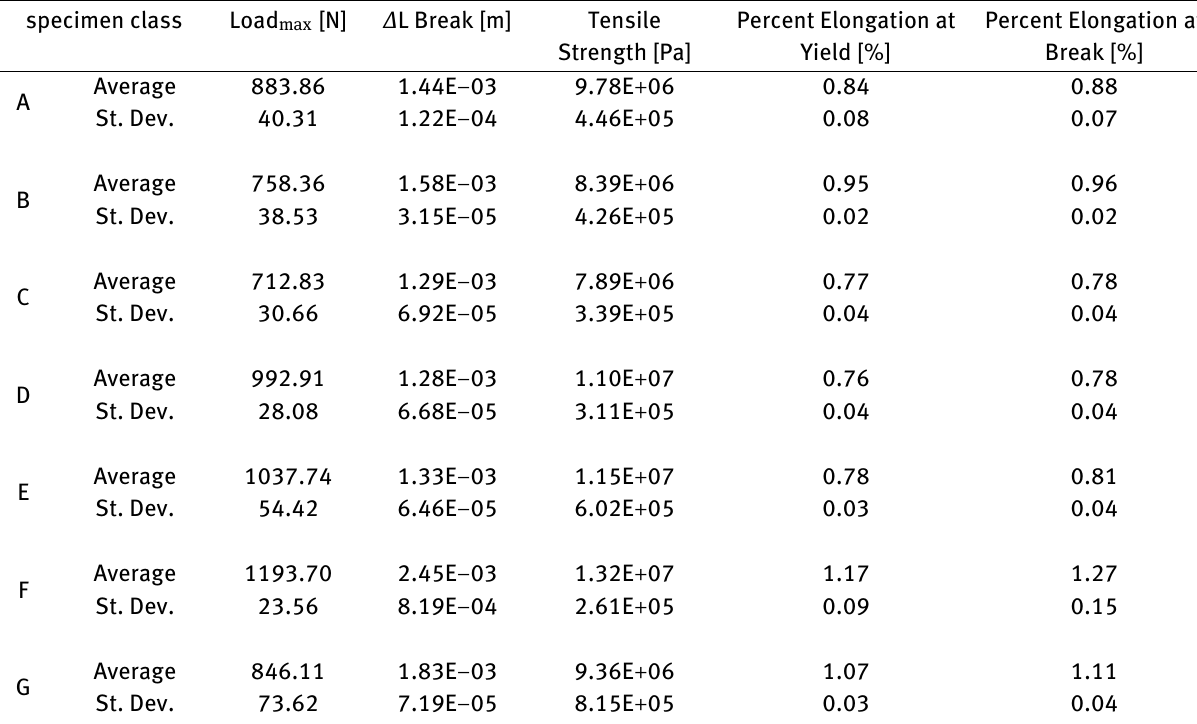
Table 3: Results from the tensile test according to the ASTM-D638 standard specimen